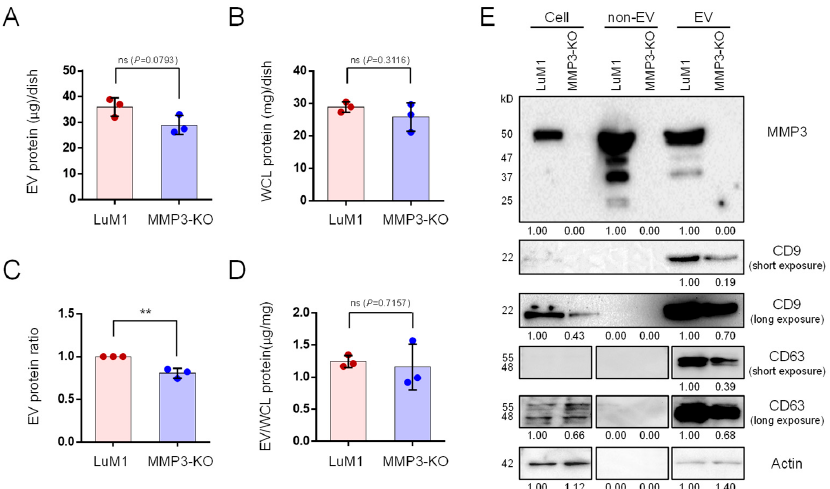
Figure 1. MMP3 knockout reduces the release of CD9 and CD63 within extracellular vesicles. Tumoroids were formed in 10-cm ultra-low attachment (ULA) plates for 6 days. Extracellular vesicle (EV) and non-EV fractions were collected from the culture supernatants. ( A , B ) The total protein concentration in the ( A ) EV and ( B ) whole cell lysate (WCL) fractions of LuM1-tumoroids and MMP3-KO tumoroids. ( C ) Relative EV protein ratio comparing two cell lines. ( D ) EV protein concentration per the WCL proteins. ** p < 0.01; ns, not significant. ( E ) Western blotting showing MMP3, CD9, CD63, and β -actin in tumoroids, non-EV, and EV fractions. The 54-kD bands indicate the full-length MMP3, the 47-kD bands represent the active form consists of the catalytic, hinge, and PEX domains, the 37-kD represents the catalytic domain, and the 25-kD shows the PEX domain of MMP3. The expression level of β -actin was examined as a loading control as well as to check if it was released from cells. The protein amounts loaded from WCL and EV fractions were 10 μ g per lane, while 5 μ g per lane were loaded from the non-EV fractions. The experiments were repeated twice. For full images of Western blotting, see Figure S1.